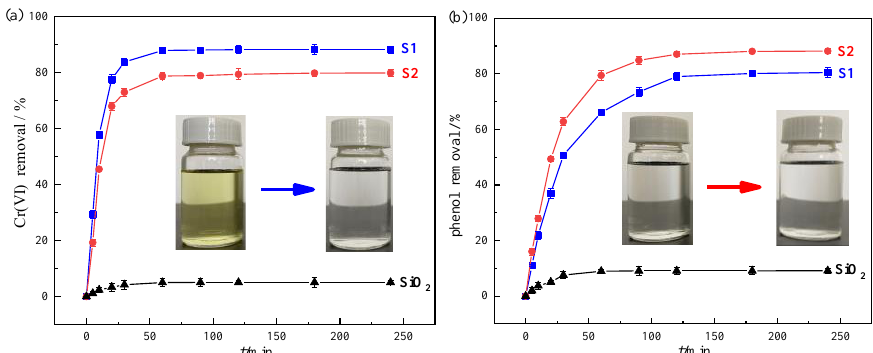
Figure 4. Adsorption kinetics of ( a ) Cr( Ⅵ ) or ( b ) phenol on SiO 2 -g-PBA-b-PDMAEMA and SiO 2 (C 0